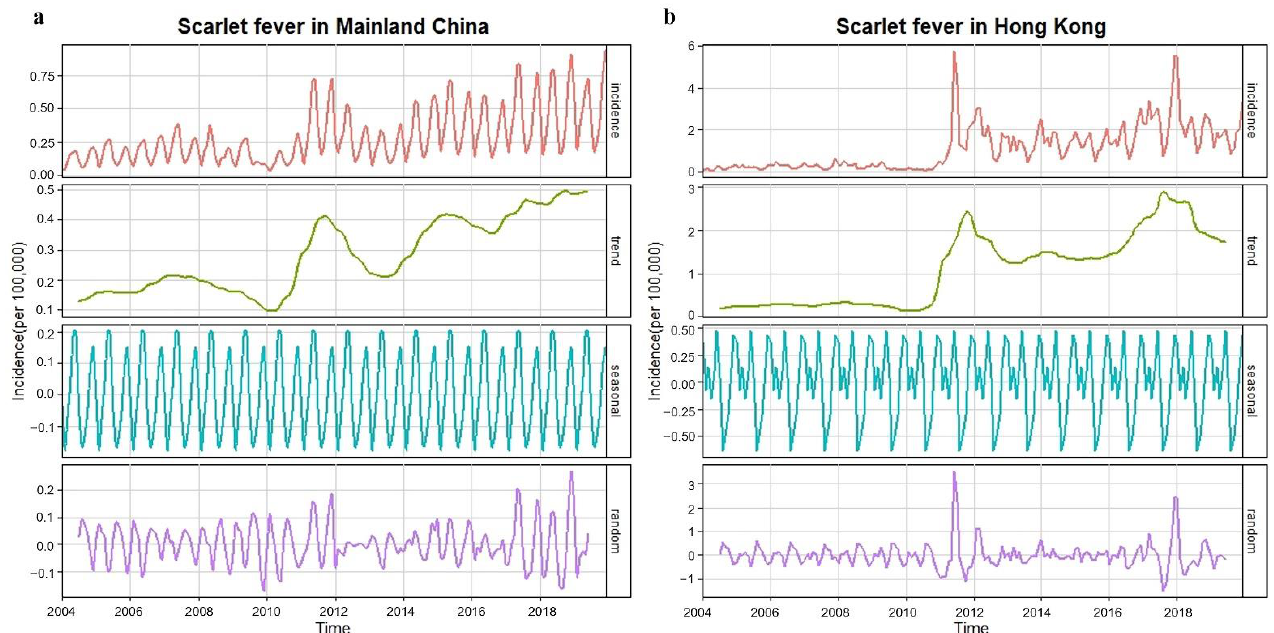
Figure 5. Monthly incidences (1/100,000) in the period 2004–2019 of scarlet fever and long-term trends, seasonal fluctuations, and random fluctuations. ( a ) Scarlet fever in Mainland China; ( b ) scarlet fever in Hong Kong.